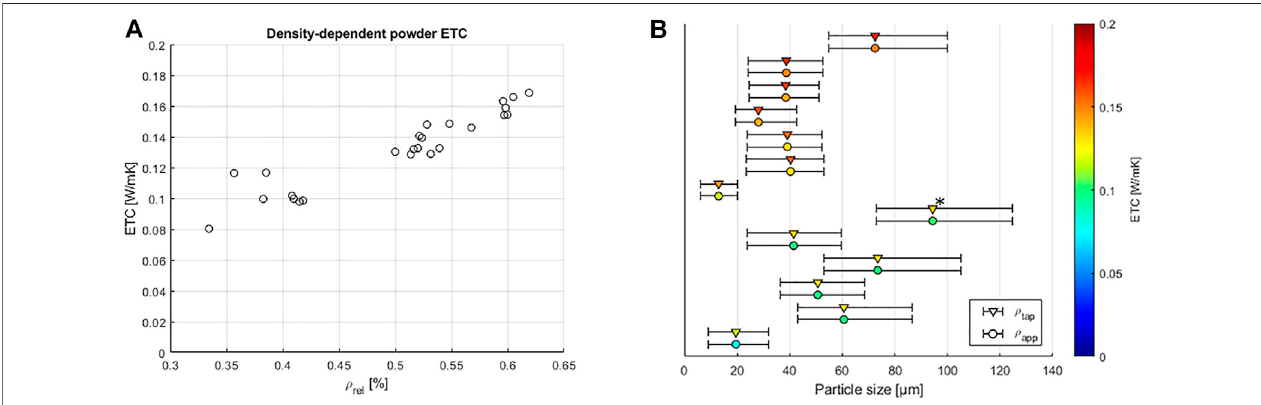
FIGURE 6 | Results of powder ETC measurements: (A) Density-dependent, (B)